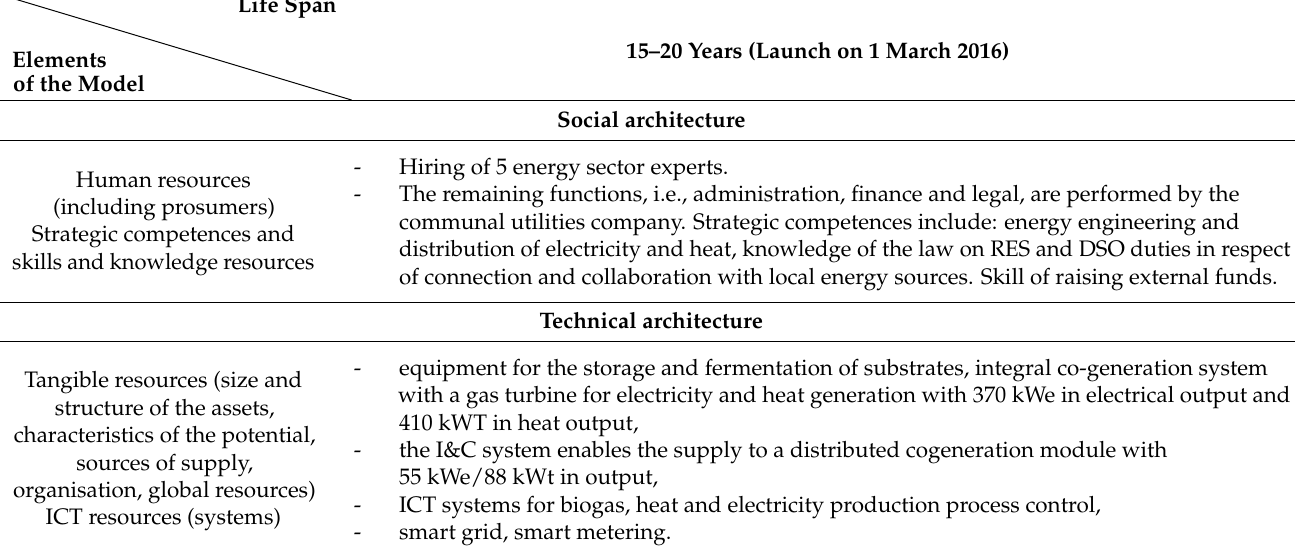
Table 8. Elements and properties of the municipal biogas plant business